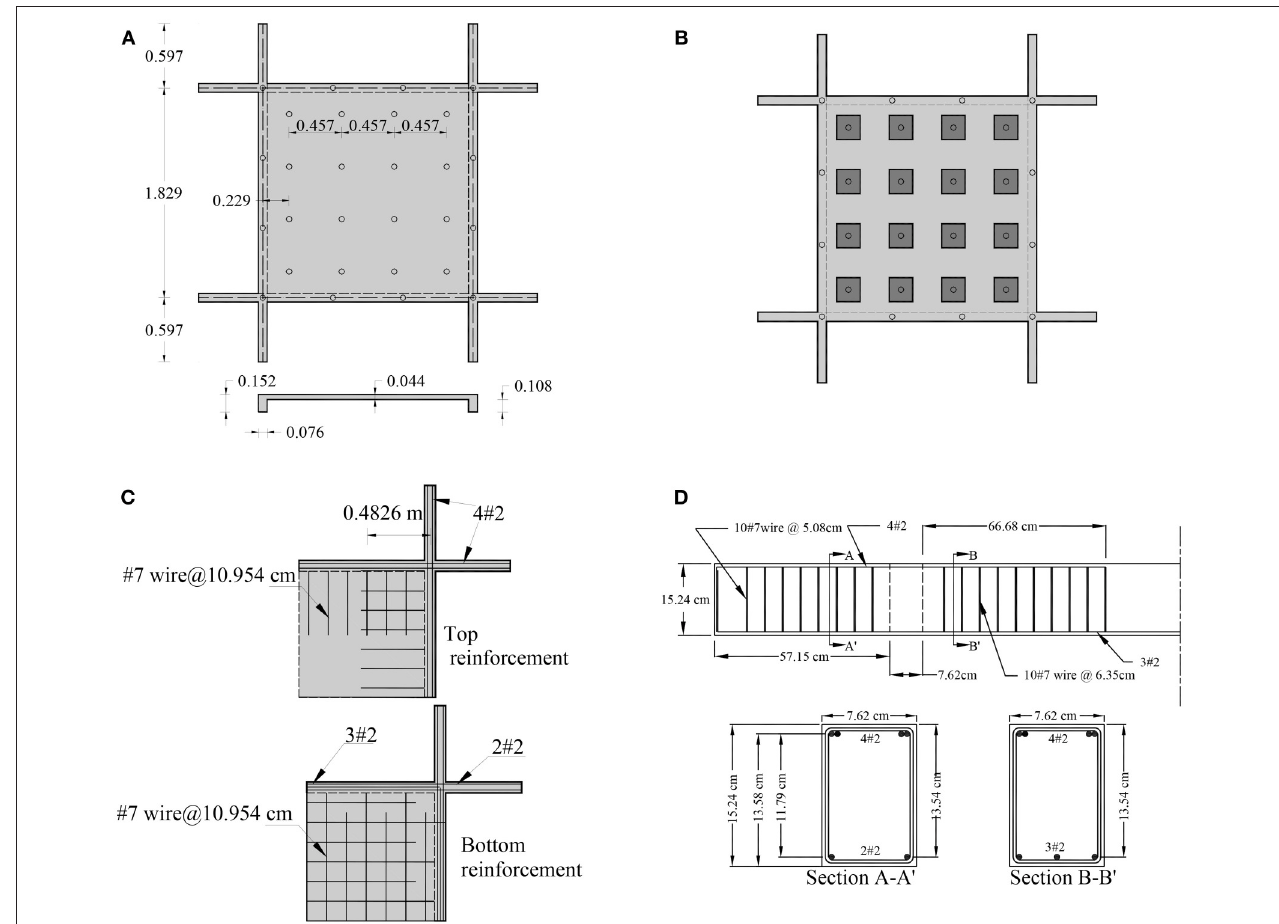
FIGURE 4 | Meshing: (A) steel reinforcement and (B) reinforced concrete.